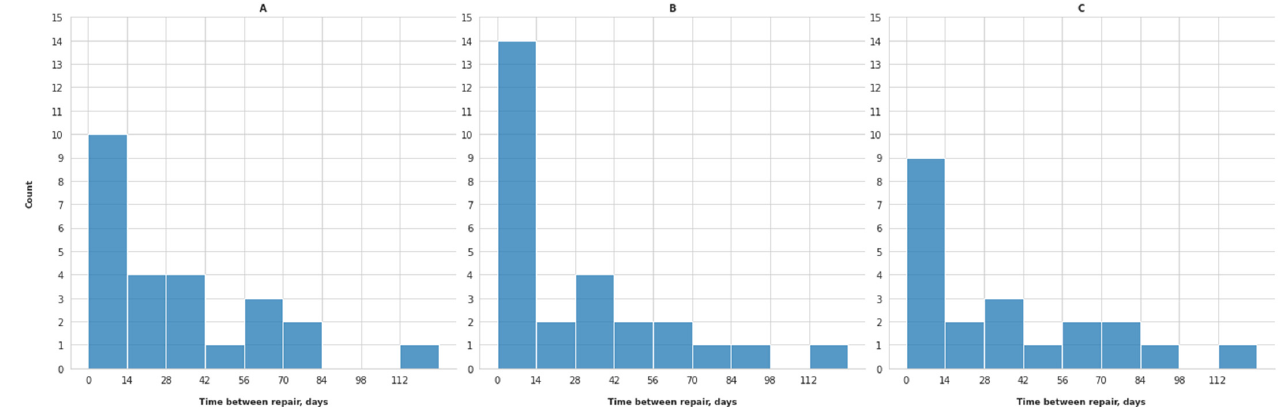
Figure 10. Histograms of time between repairs of ( A ), ( B ), and ( C ) elements in mining unit named II.